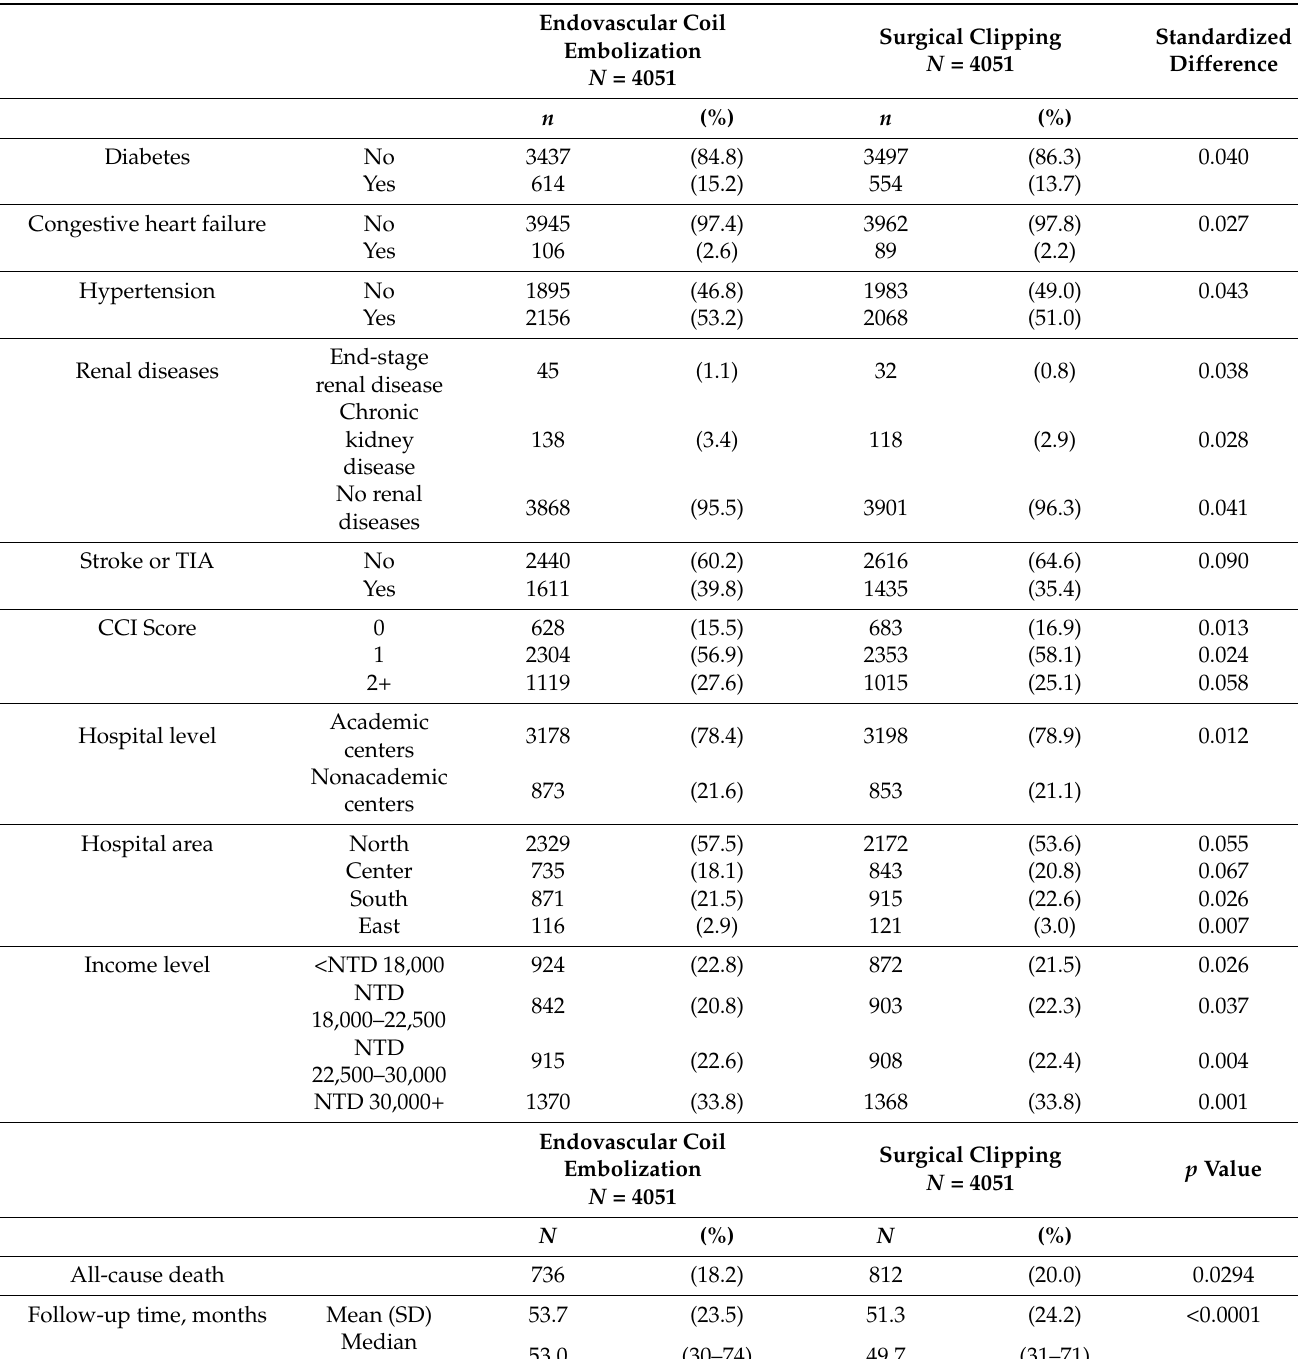
Table 2 lists the accumulative hospital stay (days) of index hospitalization stratified by surgical modality. The mean accumulative hospital stay significantly differed between the coiling (31.2 days) and clipping (46.8 days) groups ( p < 0.0001). After the generalized linear model adjustment of gamma distribution with a log link, compared with the